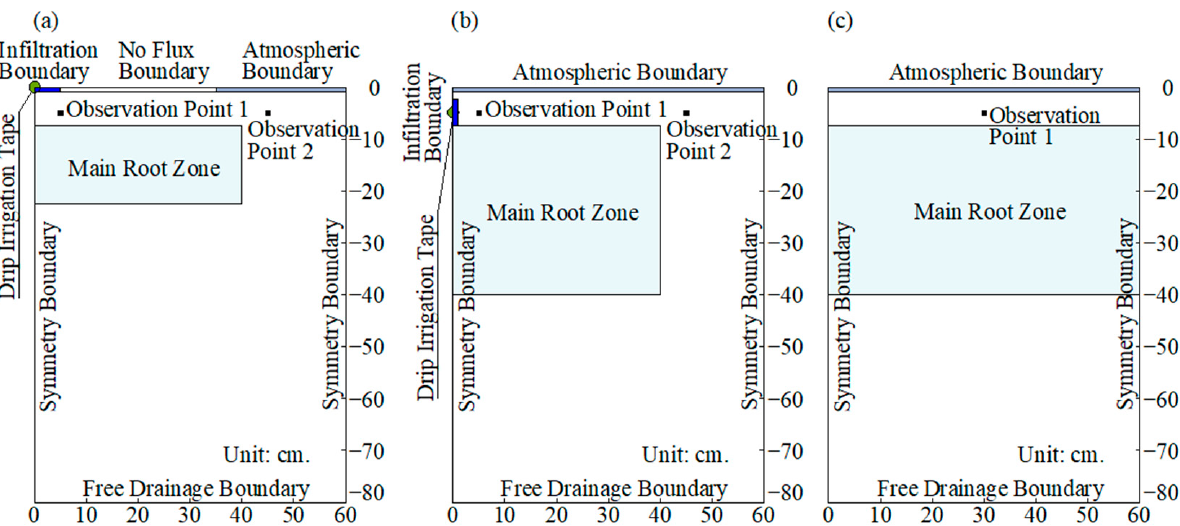
Figure 6. Schematic of soil water and salt transport simulation model. ( a ) Mulched drip irrigation; ( b ) shallow-buried drip irrigation; ( c ) sprinkler irrigation.